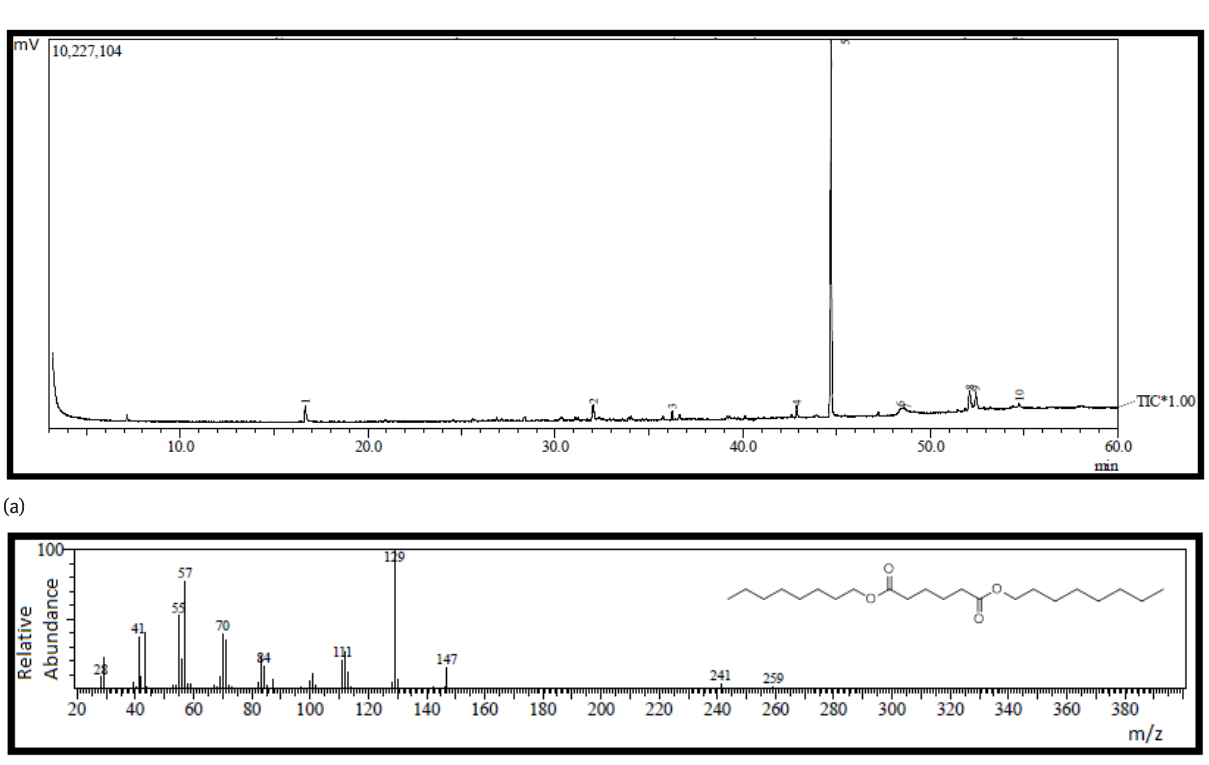
Figure 4 : Chromatogram (a) and mass spectra (b) from first major compound,